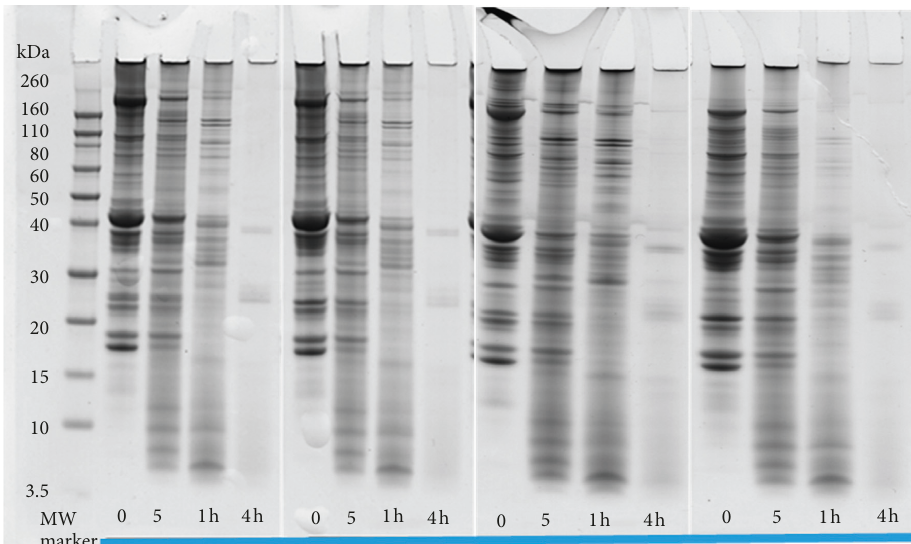
Figure 6: Experiment 3: SDS PAGE showing the effect of muscle type/cut on the digestibility of protein in cooked meat from prime heifers. Result at T0, T5, and T60 of gastric phase and T240 of intestinal phase for one of the five animals in this experiment are presented as examples. L to R extensors and flexors, rhomboideus, infraspinatus, and supraspinatus.